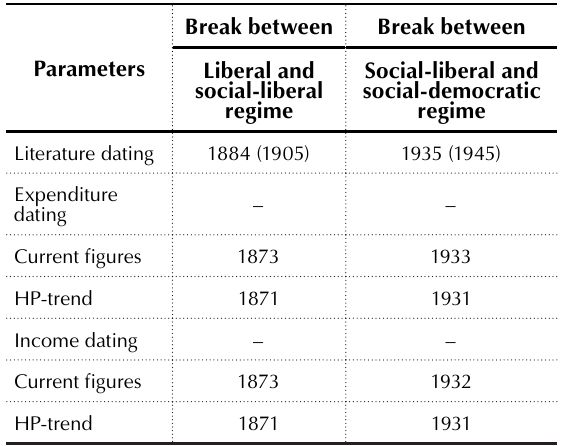
Table 1. Central government policy regimes according to literature and according to quantification of sector